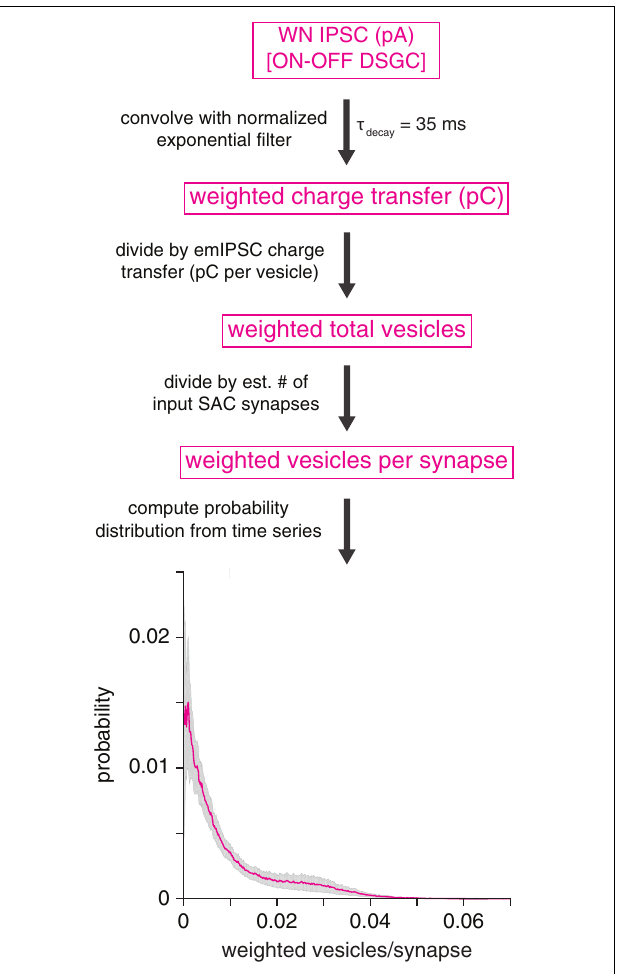
FIGURE 8 | GABA A receptor desensitization is unlikely to explain prolonged IPSCs in DSGCs. Analytical procedure for estimating the average number of vesicles driving fast GABA A receptor desensitization at a SAC synapse onto an ON-OFF DSGC. Top , an IPSC is convolved with an exponential filter (peak-normalized), which approximates the time course of fast ( τ = 35 ms) GABA A receptor desensitization. Subsequent operations generate a probability distribution of vesicles per synapse. Bottom , average probability distribution for estimated number of vesicles driving fast desensitization at a GABAergic SAC synapse onto an ON-OFF DSGC (mean of 10 cells). Shaded area represents ±